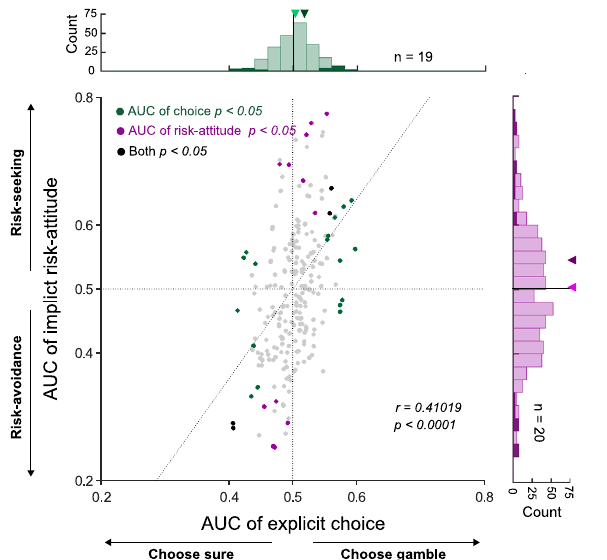
Fig. 5 Distribution of area under the curve (AUC) of receiver operating characteristic (ROC) for explicit choice and implicit risk-attitude in individual neurons. AUC values capturing the covariation of each neuron with differences in explicit choice (choosing gamble or sure) and implicit risk-attitude (risk-seeking or risk-avoidance). Each point represents one neuron ( n = 240), and colors indicate the signi fi cance of the two AUC values. The gray vertical and horizontal dashed lines show the area of no signi fi cant discrimination ability (AUC of choice = 0.5 and AUC of risk- attitude = 0.5). The broken line represents the linear regression relating the AUC of explicit choice and AUC of implicit risk-attitude ( r and p values refer to the regression slope). In the marginal distributions, signi fi cant neurons are indicted in darker shades and the arrowheads indicate the average values across the entire distribution (light green or light purple) and the subset of neurons with signi fi cant AUC (dark green or dark purple), respectively. Table 3 The number of each signal during the choice period in the force choice trial, recounted based upon the AUC for explicit choice or implicit